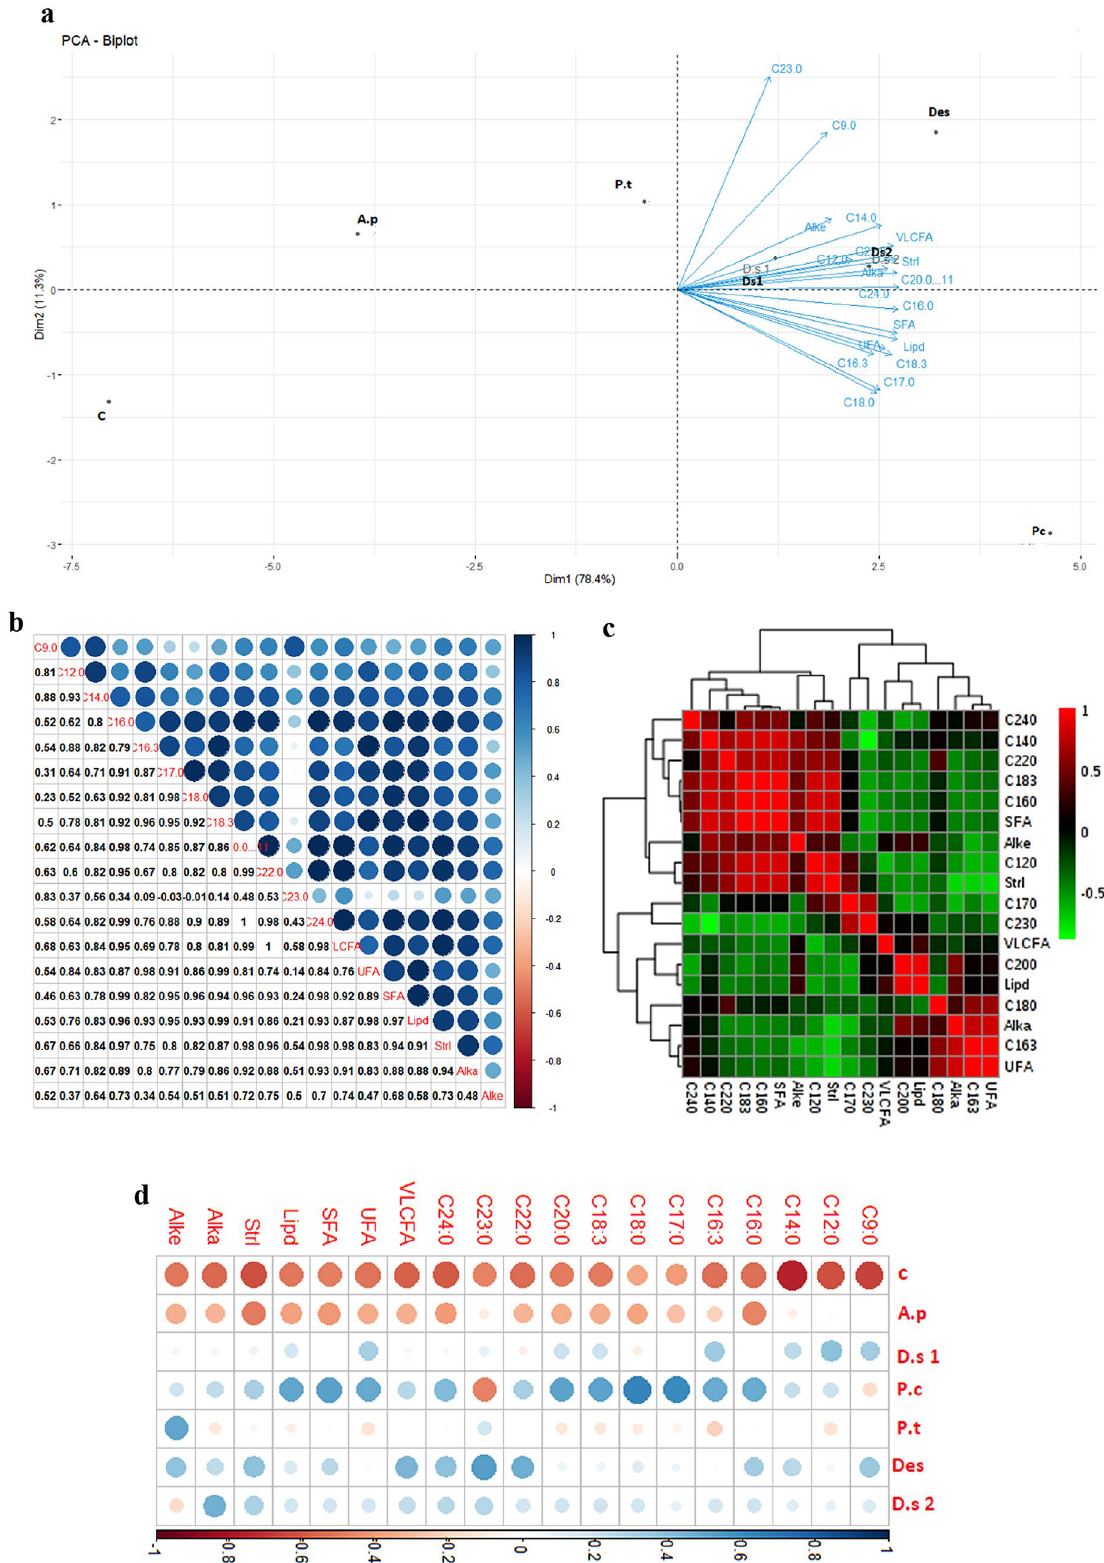
Figure 5. PCA-Biplot of metabolites and treatments ( a ), Correlation between metabolites ( b ), Heatmap Heatmap hierarchal clustering of metabolomics variable ( c ), and Heatmap of metabolites and treatments ( d ), after plant treatment by microalgae PS extract. C: Control; A.p: A. platensis; P.c: Porphyridium sp. ; P.t: P. tricornutum; D.s1: D. salina 002; D.s2: D.salina 067; Des: Desmodesmus